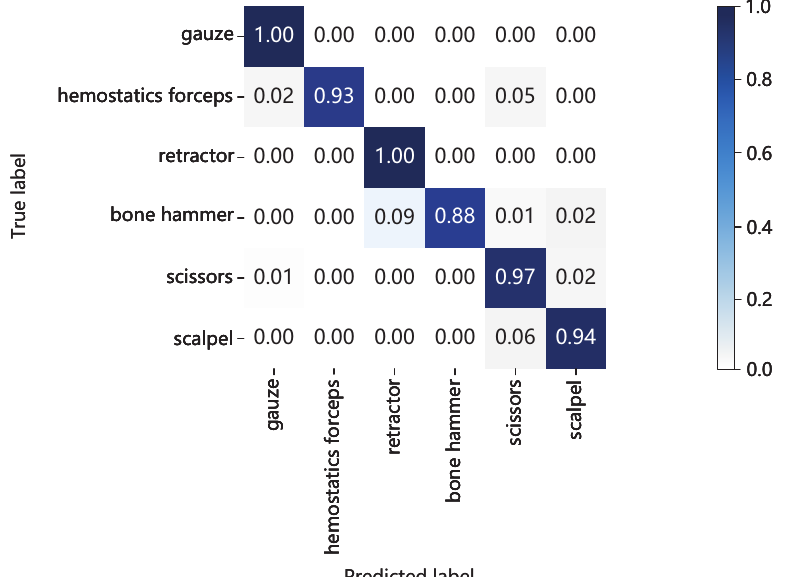
Figure 12. Confusion matrix of the improved model.